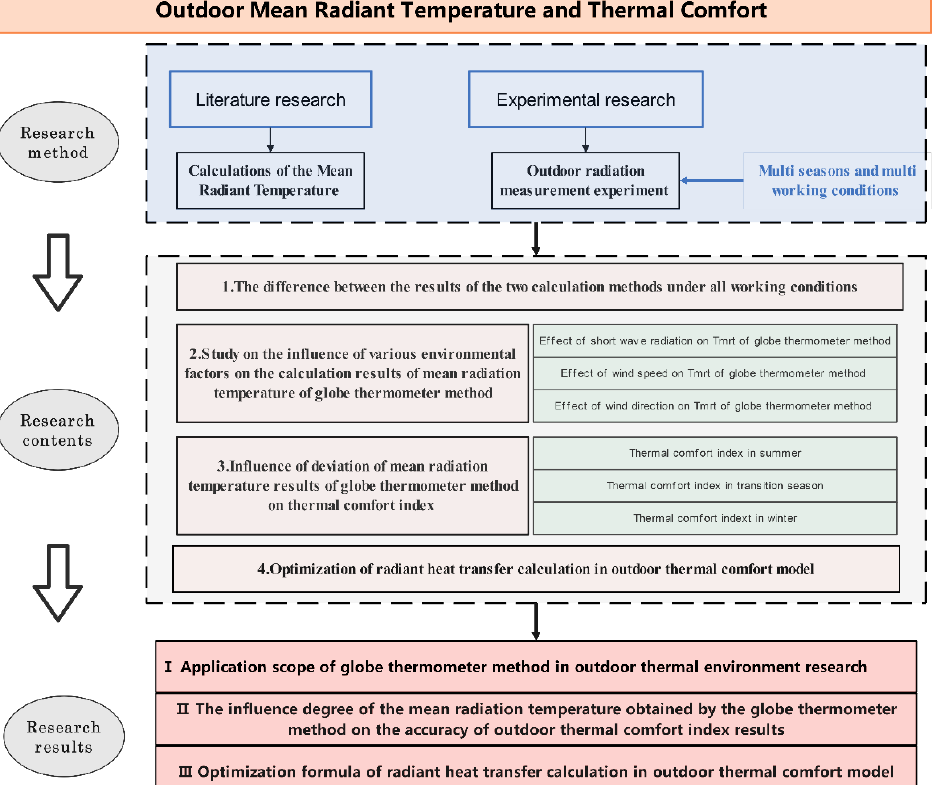
Figure 1. Technical route of this paper. (Picture source: drawn by the author.)